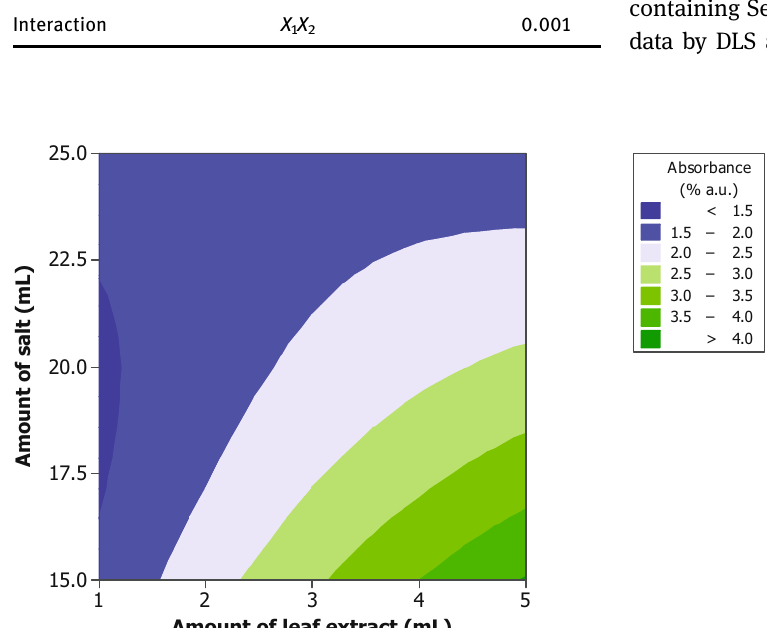
Figure 4: Contour plot for absorbance of the fabricated Se NP solution as a function of the amounts of walnut leaf extract and selenium